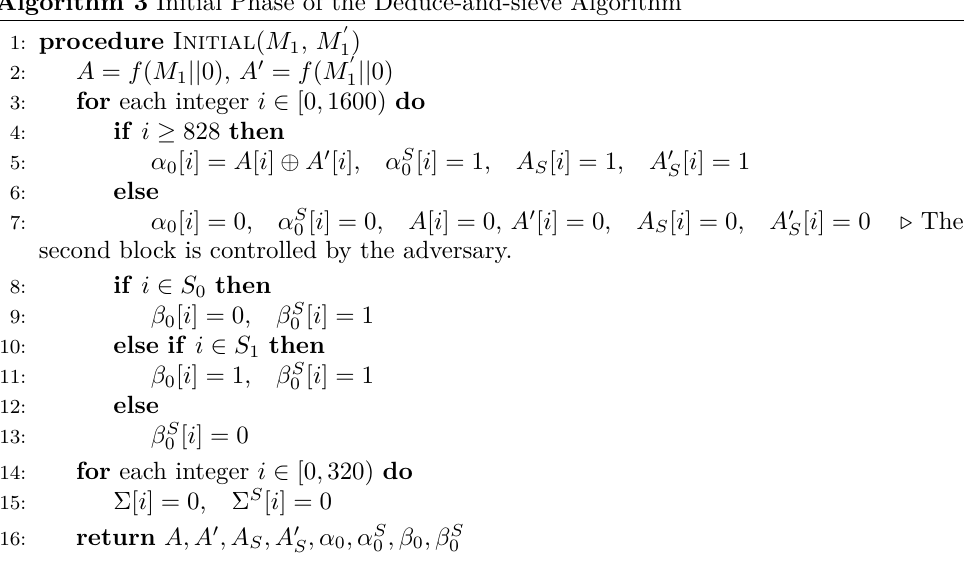
Algorithm 3 Initial Phase of the Deduce-and-sieve